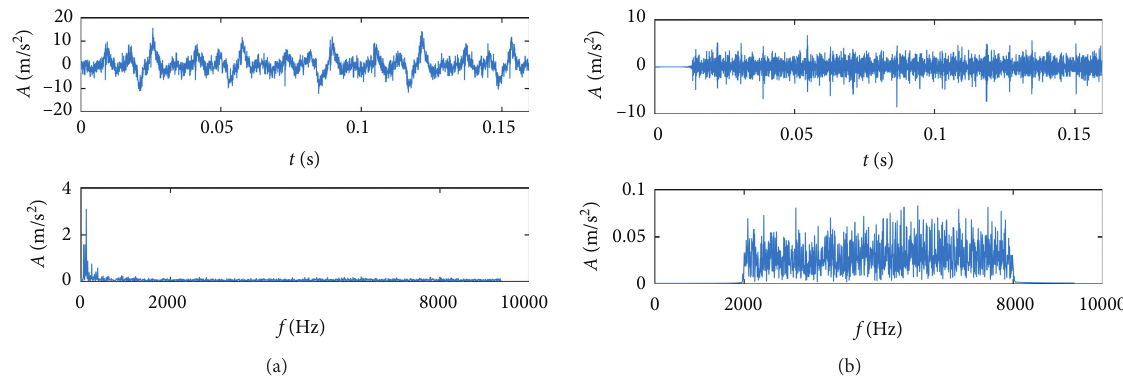
Figure 11: Vibration signal of the time domain and frequency domain under the misfire state with 5 dB white noise. (a) Original signal. (b) Filtered signal.